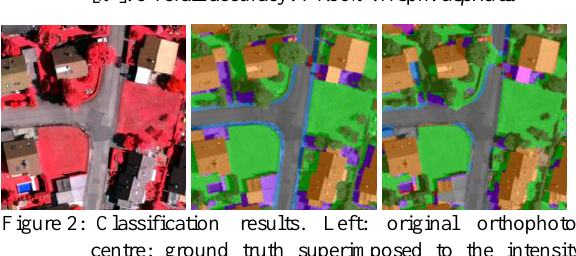
Table 4: Confusion matrix for the experiment using 8 classes without car confidence feature. All values are given in [%]. Overall accuracy: 74.39%. Asph: asphalt.